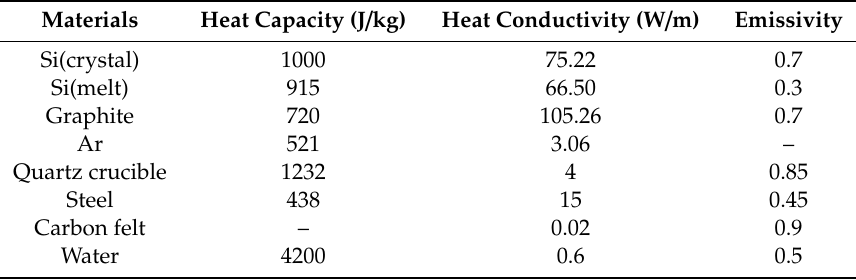
Table 1. Properties of the